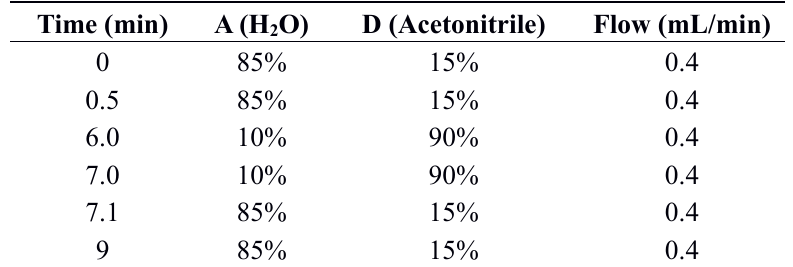
Table 1. HPLC-MS/MS mobile phase gradient elution condition.